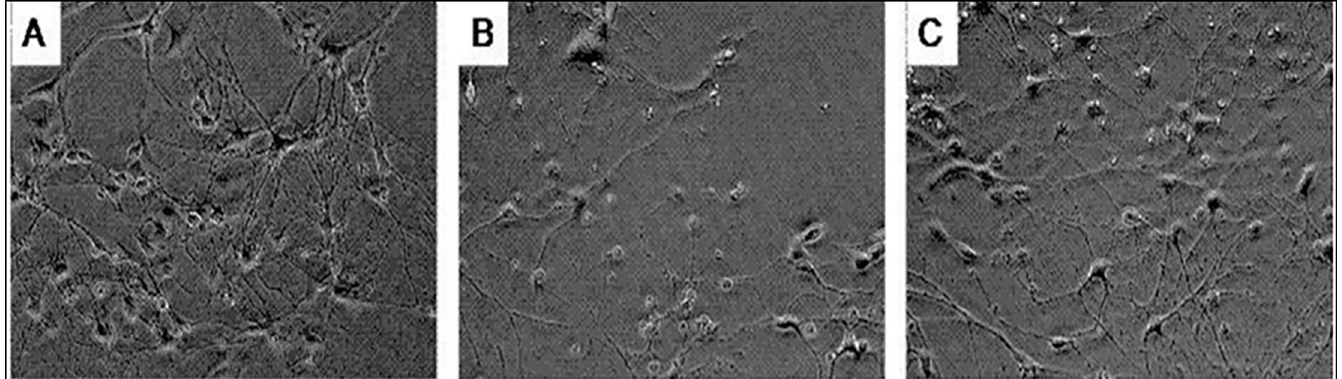
Fig 2. The changes of cell morphology of primary cultured hippocampal neurons. Primary hippocampal neuron cultures were treated with CORT (10 μmol/L) for 24 h in the absence or presence of EGCG pretreatment (1μmol/L, at 30 min prior to CORT addition). A) Normal neurons, ×200; B) CORT treated neurons, ×200; C) EGCG co-incubation with CORT-treated neurons, ×200.